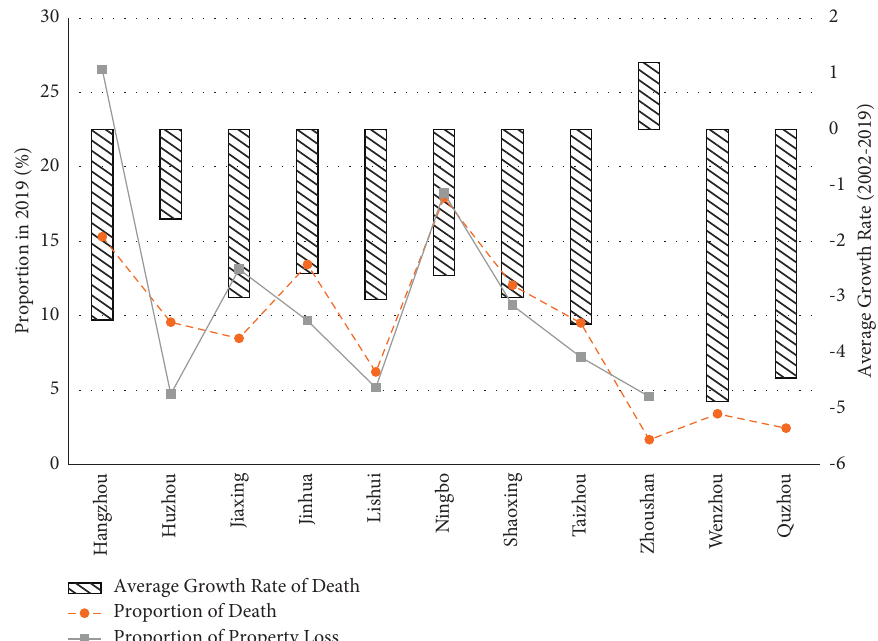
Figure 5: The proportion of death and property loss, as well as the average growth rate of deaths for 11 cities in Zhejiang Province (2019).